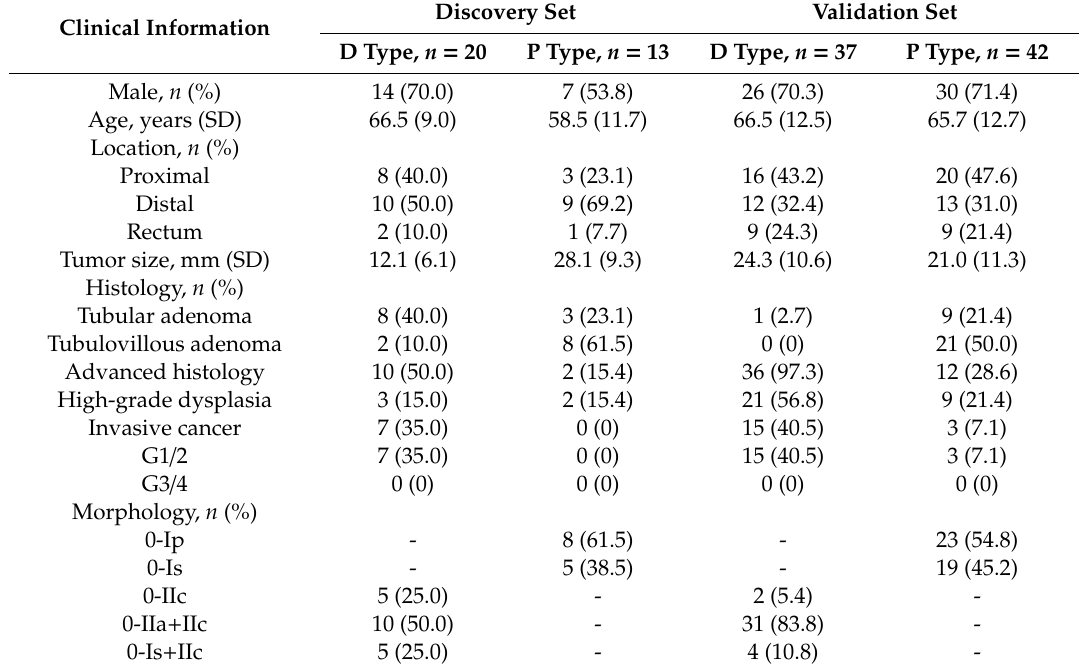
Table 1. Demographic and clinical